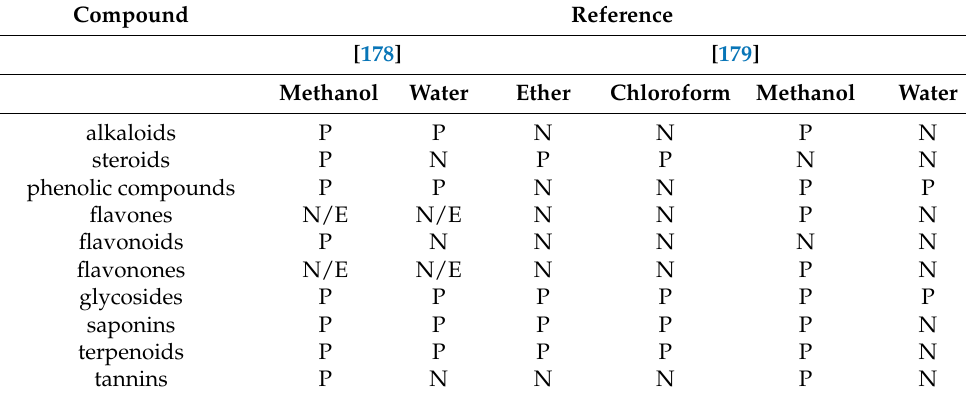
Table 5. Solvents and soluble compounds of arrowroot